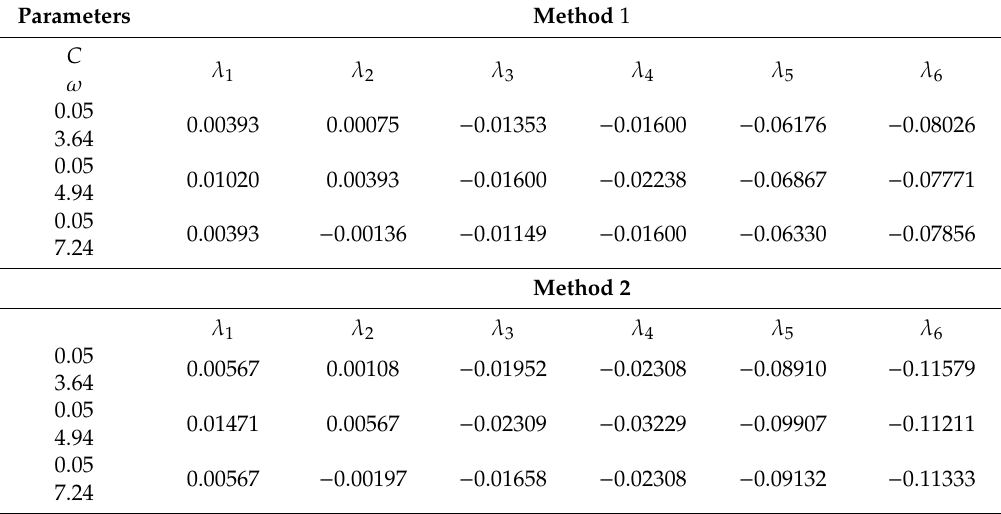
Table 7. Spectra of Lyapunov exponents for the system with elastic